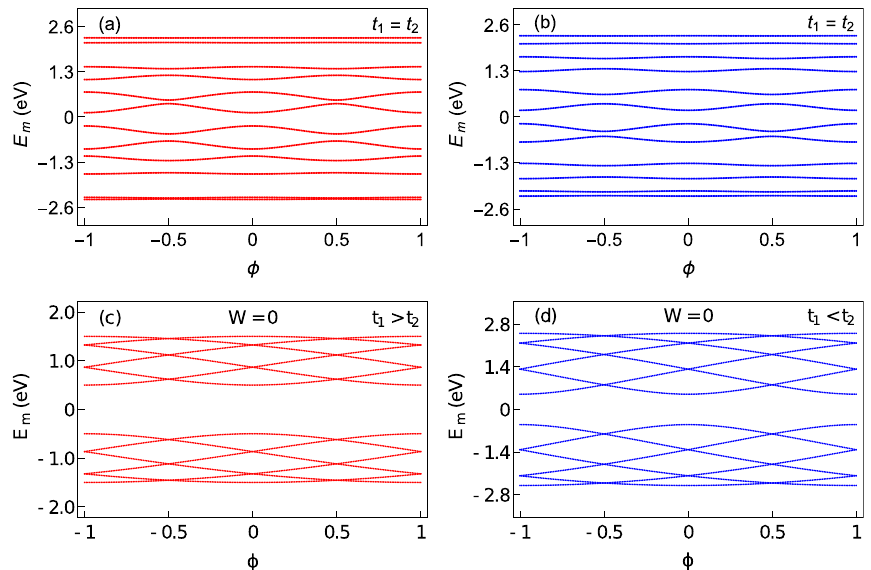
of the ring subjected to only AAH modulation with W = 1 and t 1 = t 2 = 1 , where ( a ) and ( b ) correspond to non-staggered and staggered cases, respectively. The second row denotes the results of an SSH ring (without any AAH modulation) where ( c ) t 1 > t 2 ( t 1 = 1 , t 2 = 0.5 ) and ( d ) t 1 < t 2 ( t 1 = 1 , t 2 = 1.5 ). For all these cases, we set N = 6 and φ ν = 0 .